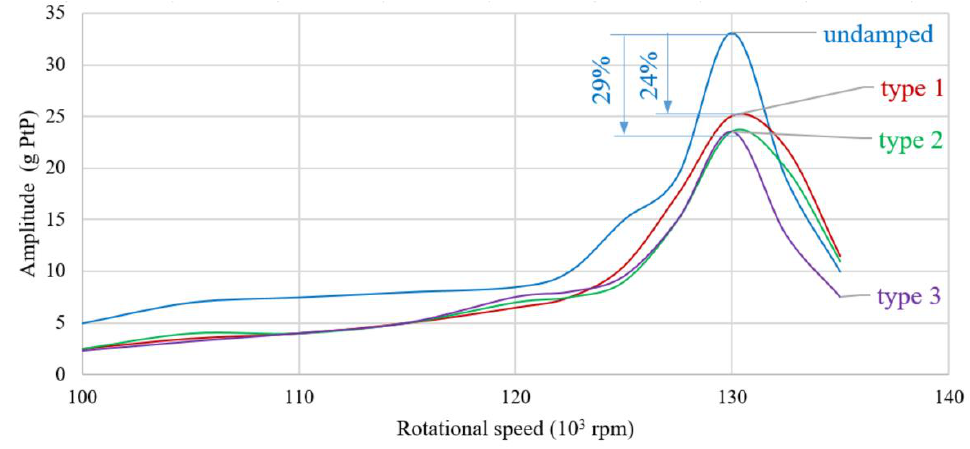
Figure 5. Time record (up) and fast Fourier transformation (FFT) spectrum (below) for a structure with no damper ( a ) and a structure with passive damper type 2 ( b ).